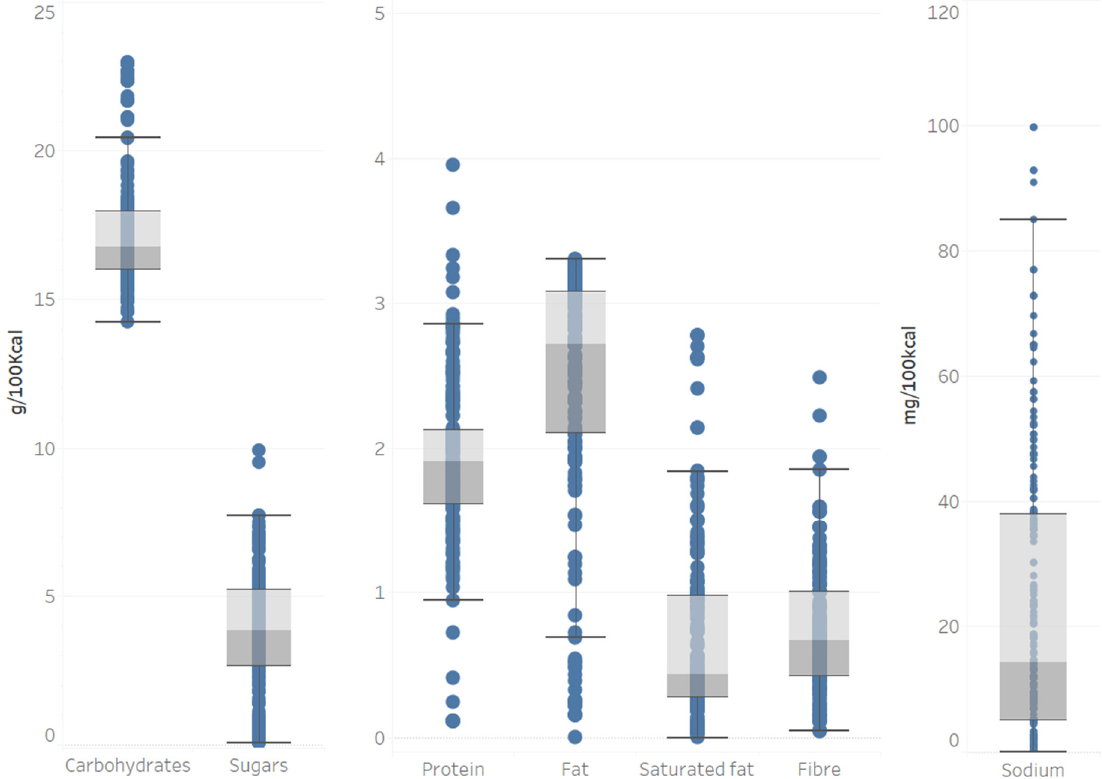
Figure A3. Nutrient content (g/100 kcal product, except for sodium mg/100 kcal product) of ‘Baby biscuits and rusks’.